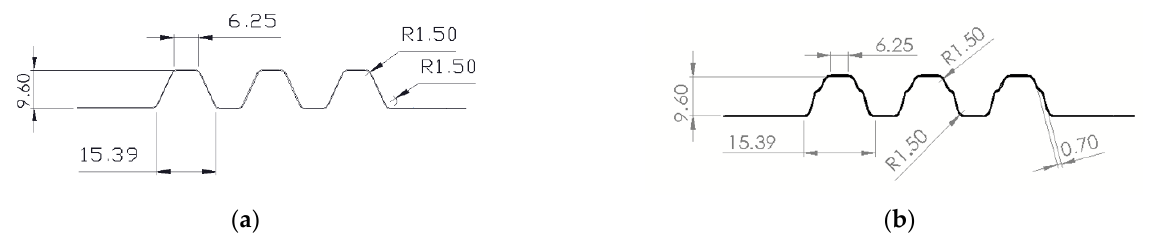
Figure 1. Flow channel features with fillet radii of ( a ) 0 and ( b ) 0.70 mm.